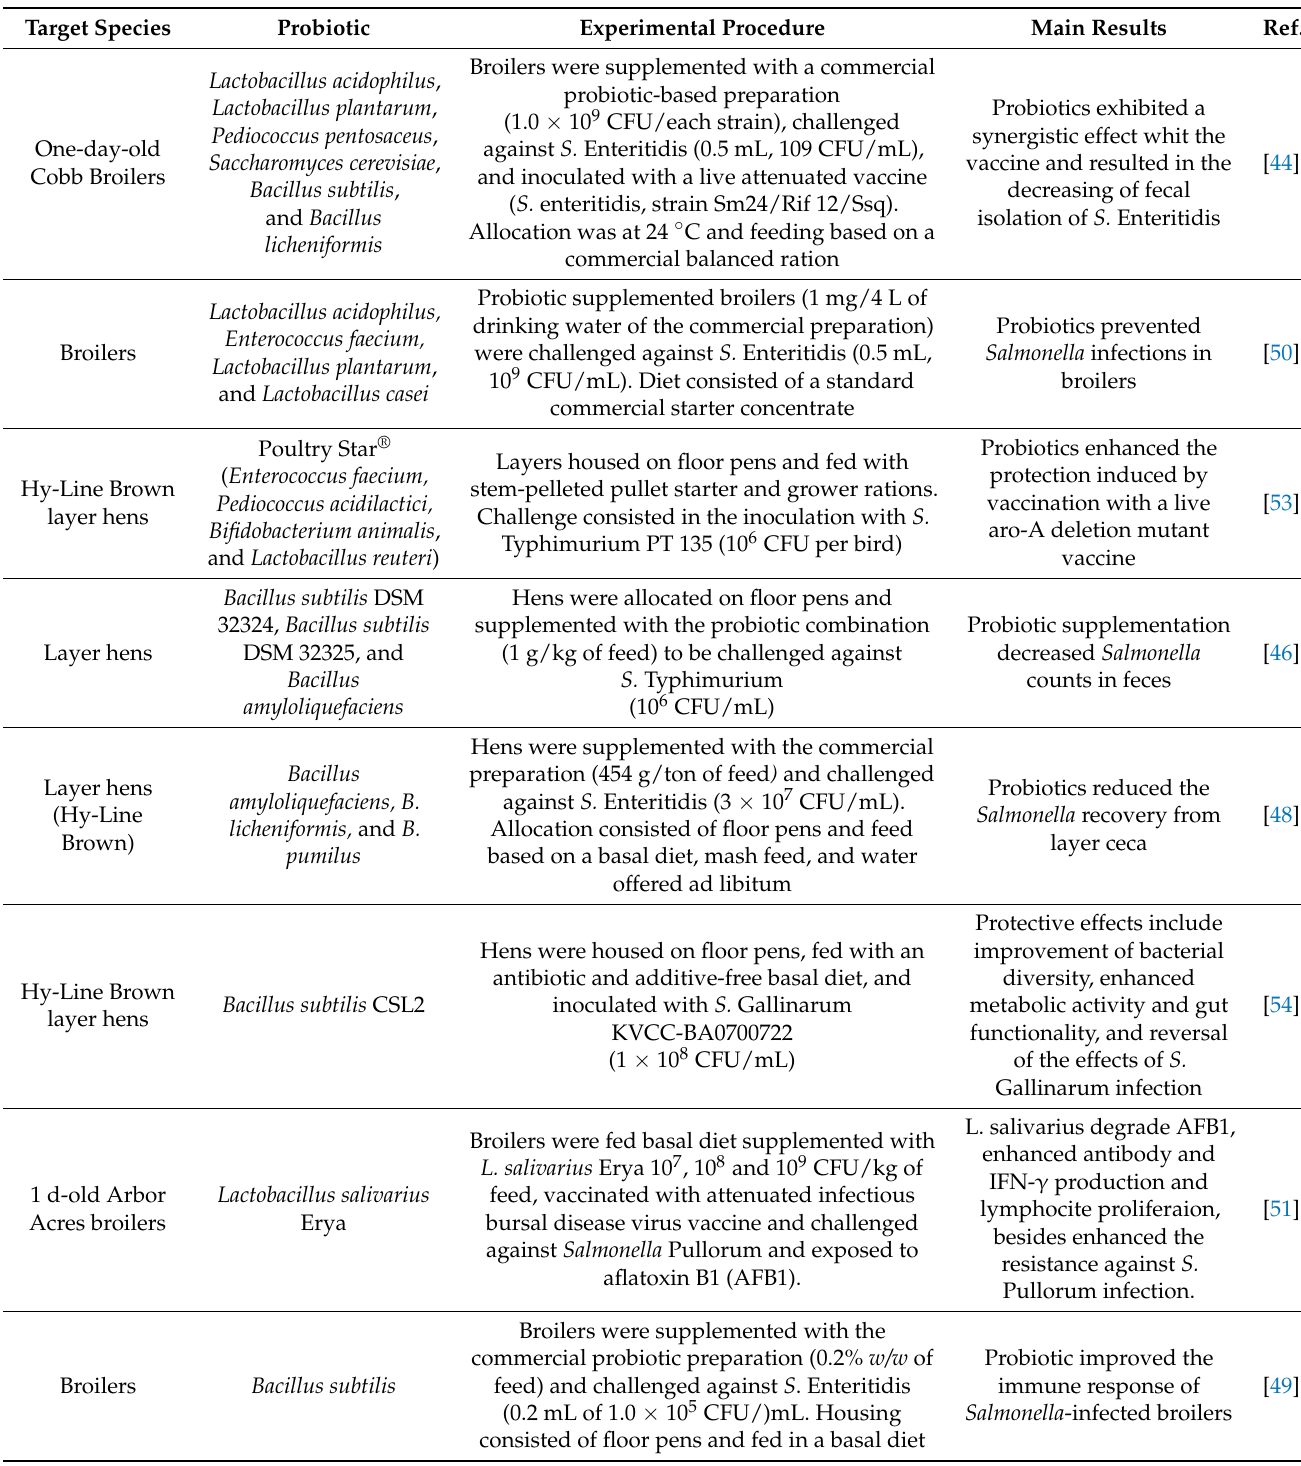
Table 2. Effects of dietary supplementation of probiotics as a strategy to control Salmonella in